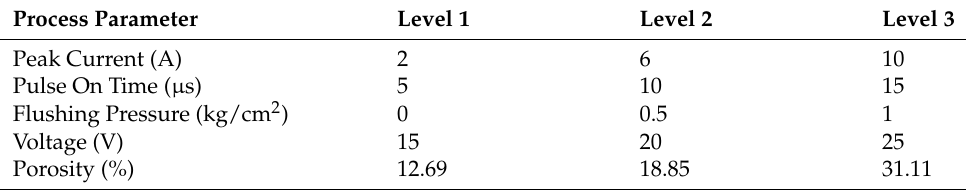
Table 2. Input Process Parameters and Their Levels.